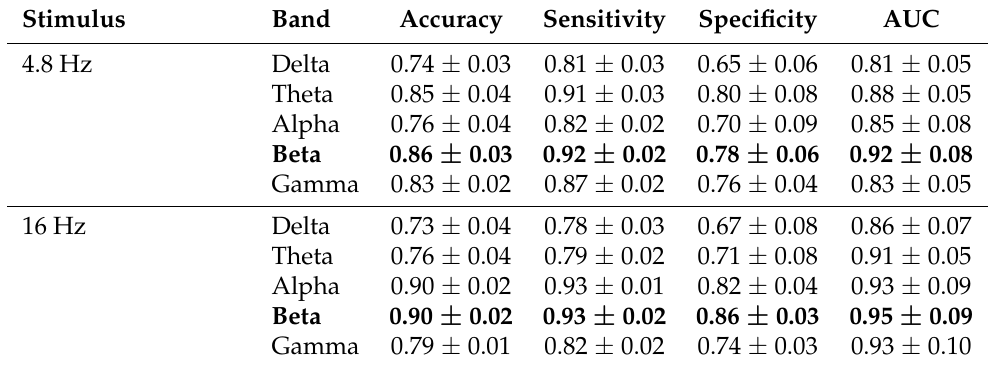
Table 2. Summary of the best classification results obtained for the different EEG bands. Bands providing the best accuracy values are highlighted in